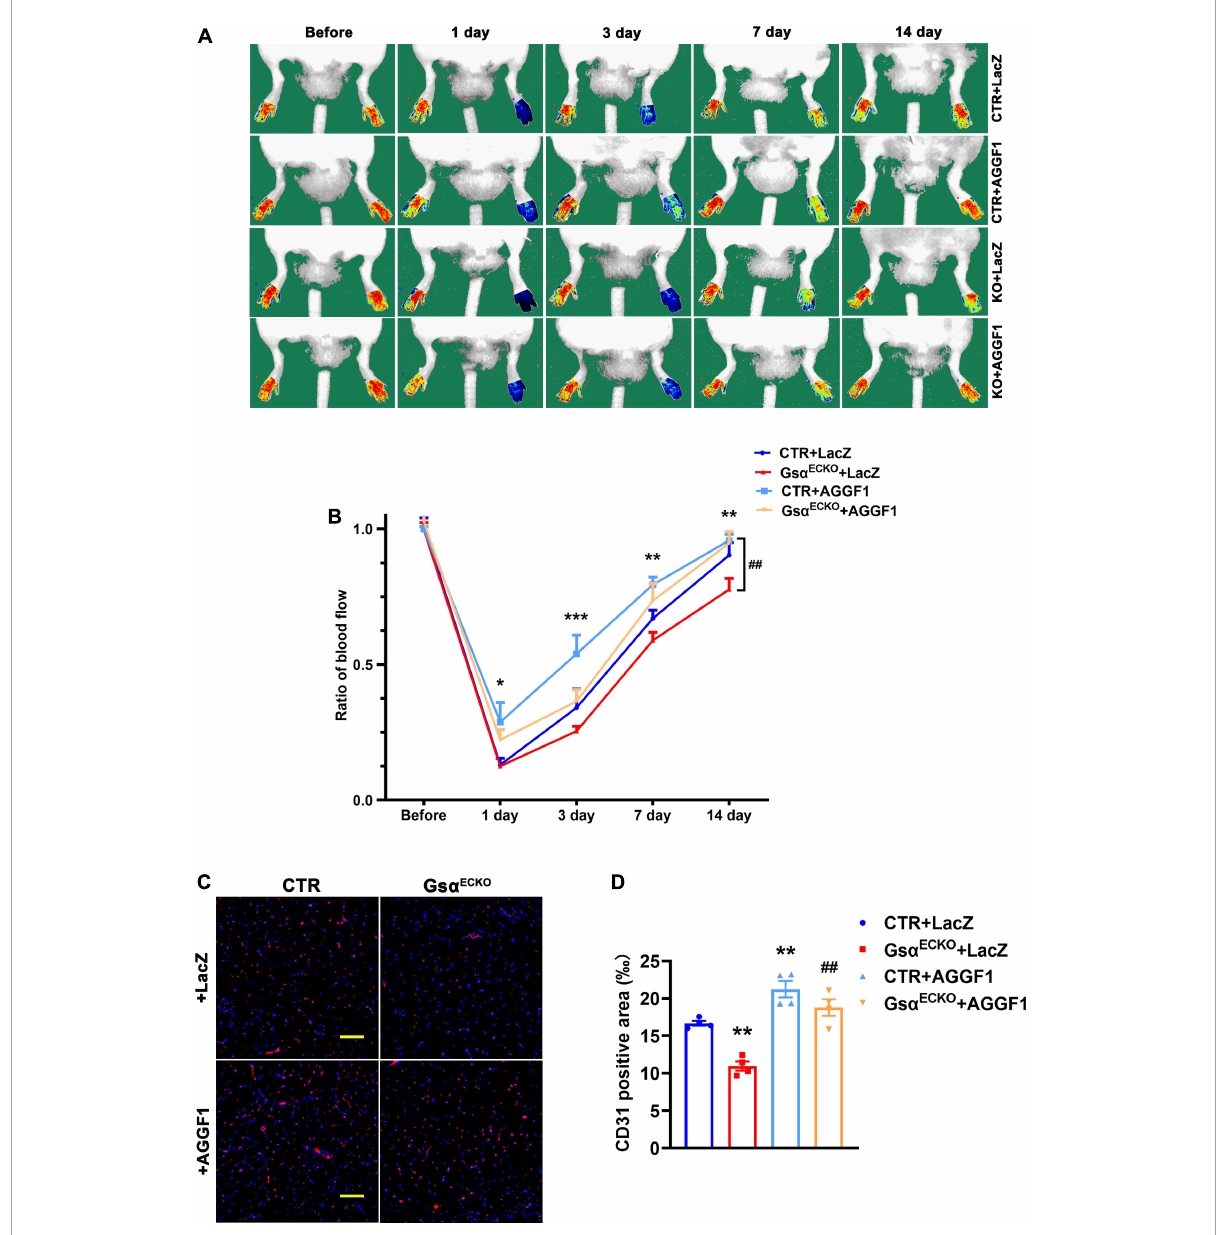
FIGURE7 Adenoviral overexpression of AGGF1 alleviates the impaired angiogenesis in Gs α ECKO mice. (A) CTR and Gs α ECKO mice were injected with adenovirus expressing LacZ or AGGF1 (10 9 PFU/mouse) followed by hind-limb ischemia assay. Representative images of blood flow before or on days 1, 3, 7, and 14 after femoral artery ligation. (B) Quantification of blood flow in ischemic hind limbs. Data are expressed as a ratio of ischemic to non-ischemic hind-limb perfusion. n = 5/group, * P < 0.05, ** P < 0.01, *** P < 0.001 vs. CTR + LacZ; ## P < 0.01 vs. Gs α ECKO + LacZ (One-Way ANOVA and Bonferroni post-tests). (C) Representative immunofluorescence staining of CD31 and DAPI in ischemic gastrocnemius muscle of mice. Scale bar, 100 µ m. (D) Quantification of CD31-positive area in (C) . n = 4/group, ** P < 0.01 vs. CTR + LacZ; ## P < 0.01 vs. Gs α ECKO + LacZ (One-Way ANOVA and Bonferroni post-tests). Data are mean ±